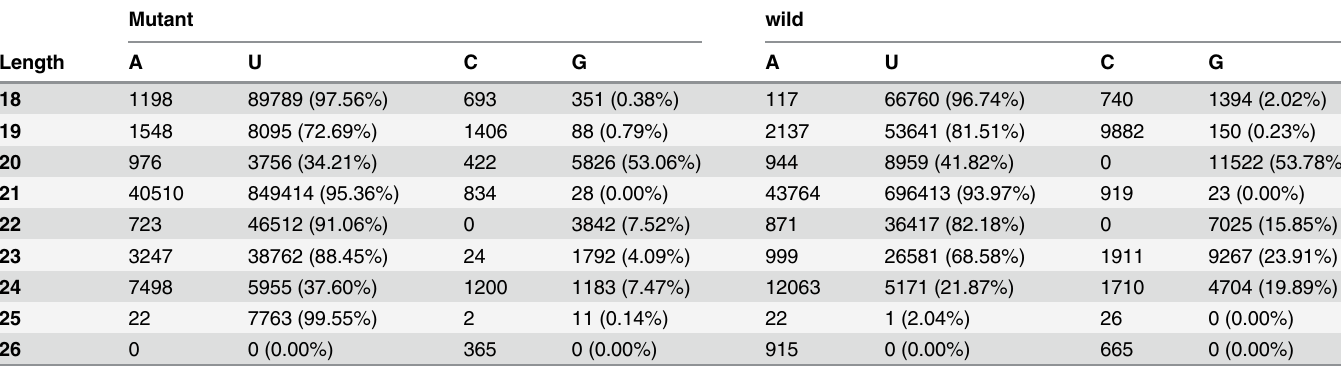
Table 6. Distribution of miRNA nucleotide bias.